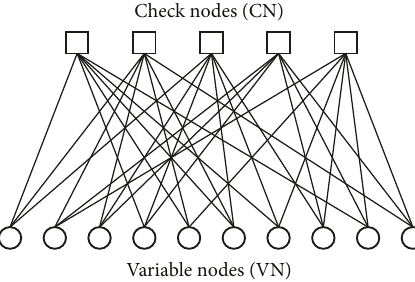
Figure 3: A Tanner graph where the variable nodes (VN), repre- senting the code bits, are shown as circles and the check nodes (CN), representing the parity-check equations, are shown as squares. Each edgeinthegraphcorrespondstoanonzeroentry( 1 forbinaryLDPC codes) in the PCM H